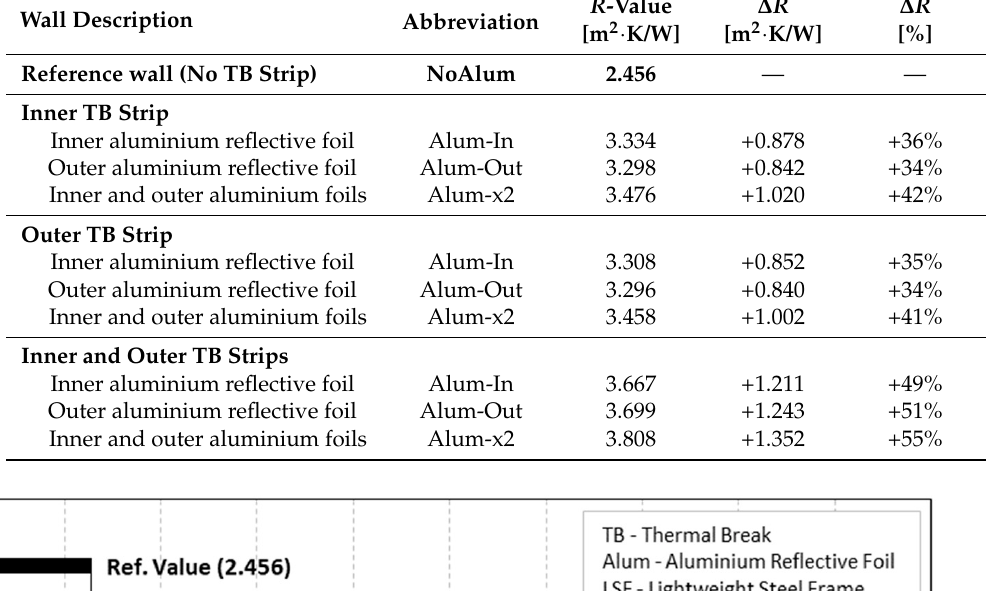
Table 6. Measured thermal resistance of double-pane LSF walls and thermal performance improve- ment due to aerogel thermal break strips and aluminium reflective foils.